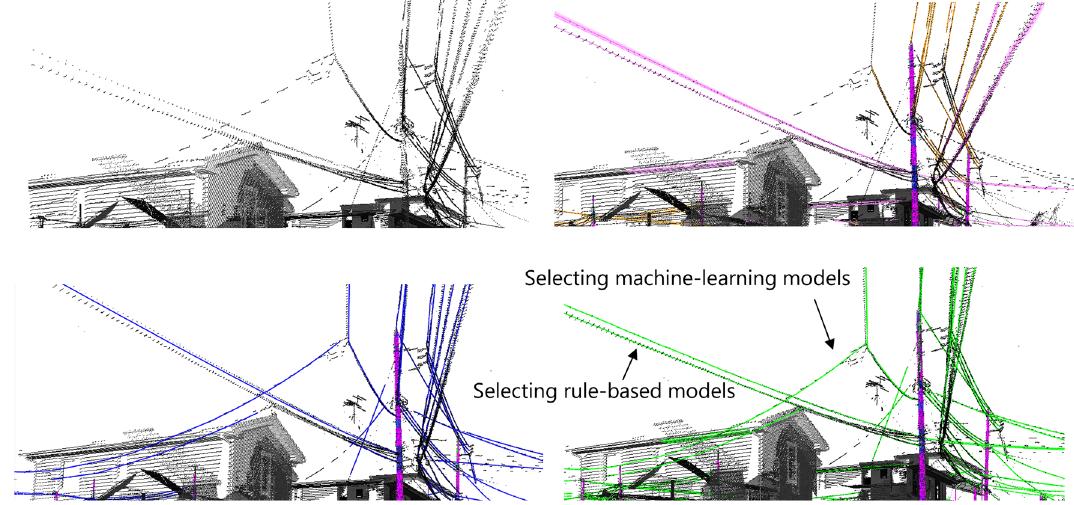
Fig. 5 (Top left) Original point cloud, (top right) 3D rule-based cable models in yellow and pink, (bottom left) 3D machine-learning cable models in blue, and (bottom right) cable model generated from combining both models in